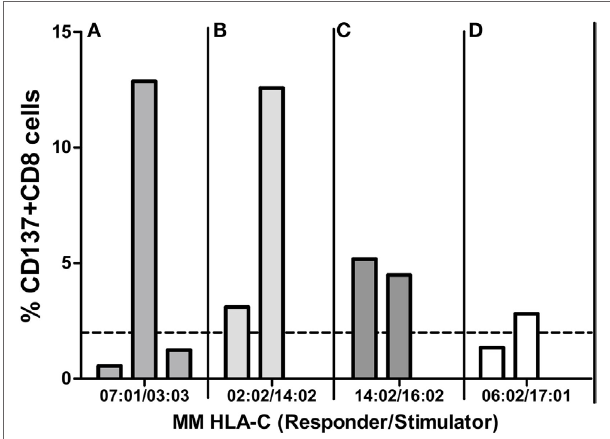
FigUre 6 | Mixed lymphocyte reactions (Mlrs) between different responders and the same hla-c MM stimulator . Each panel represents MLRs between cells of three (a) or two (B–D) responders and one stimulator. MLRs of each panel were done in parallel (i.e., at the same time) for each of the four experiments (a–D) and represent four different HLA-C MMs: the mismatched HLA-C alleles of the responder and the stimulator are indicated below each panel. Alloresponses are given as % Δ CD137 + CD8 + cells (2% cutoff indicated by the dashed line). All pairs tested in (a–c) were HLA-DPB1 mismatched. In experiment (D) , the two pairs (one positive, one negative) were HLA-DPB1